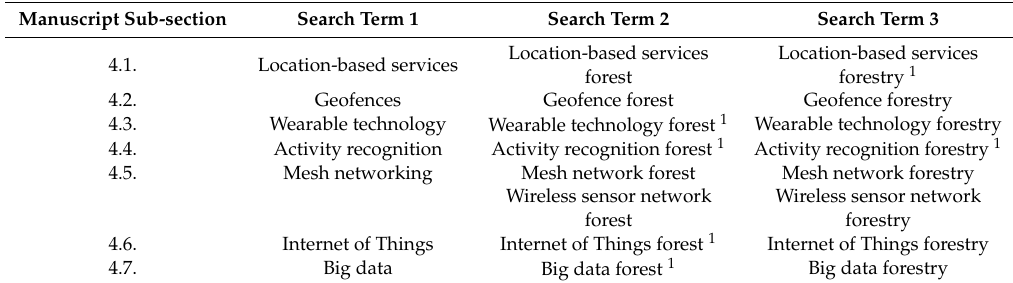
Table A2. Search terms used in Google Scholar for manuscript Section